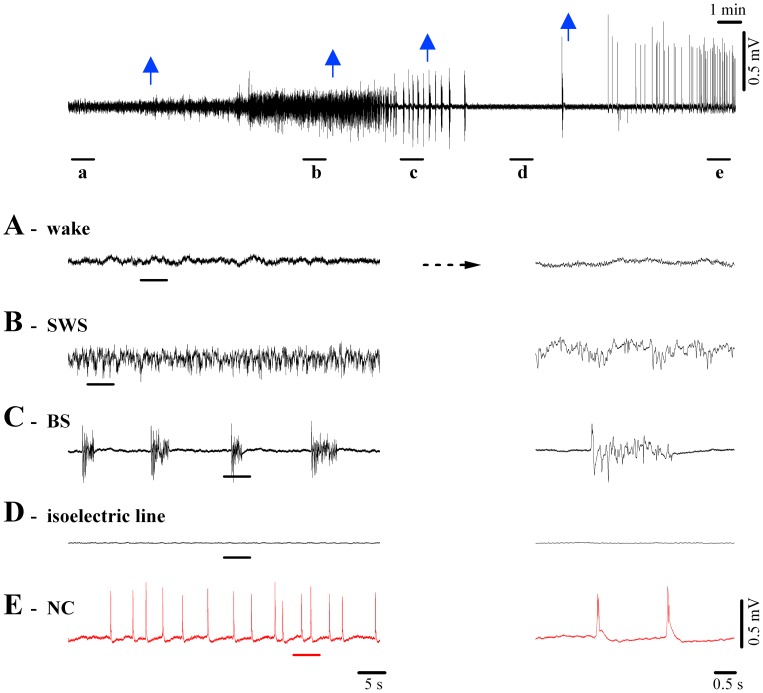
EEG patterns during wakefulness and diverse degrees of loss of consciousness.Cat EEG recording during application of various concentrations of isoflurane. Whilst the top-most panel depicts the complete sequence with arrows indicating the applications of increasing anesthesia, the underlined epochs are expanded below. (A) Undrugged preparation displaying low amplitude, fast (mostly >15 Hz) EEG. (B) Slow-wave sleep-like (SWS) pattern after 1% isoflurane, characterized by higher amplitude slow waves dominated by delta oscillations (<4 Hz). (C) Burst-suppression (BS) induced with 2% isoflurane showing alternating sequences of isoelectric line and bursting episodes. The latter are very similar to SWS patterns (see detail at right). (D) A further increase in the isoflurane concentration (3%) establishes a stable isoelectric line portraying the absence of phasic events. Only very low-amplitude activities can be observed at high gain. (E) Isoflurane at 4% elicits a revival of quasi-rhythmic spiky potentials of high amplitude, which we propose to call ν-complexes (or Nu-complexes; νC).